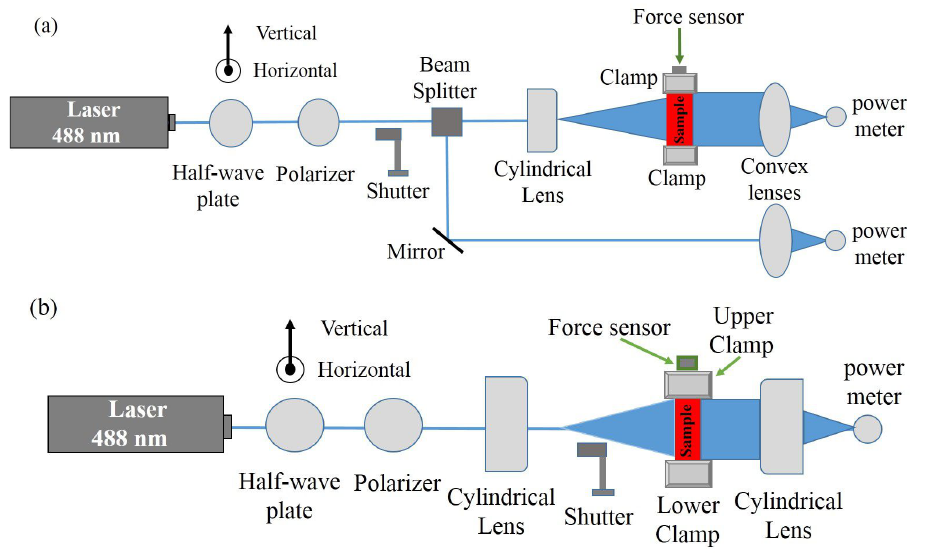
Figure 3. The optical path in the experiment to measure ( a ) Young’s modulus as a function of intensity ( b ) stress as a function of